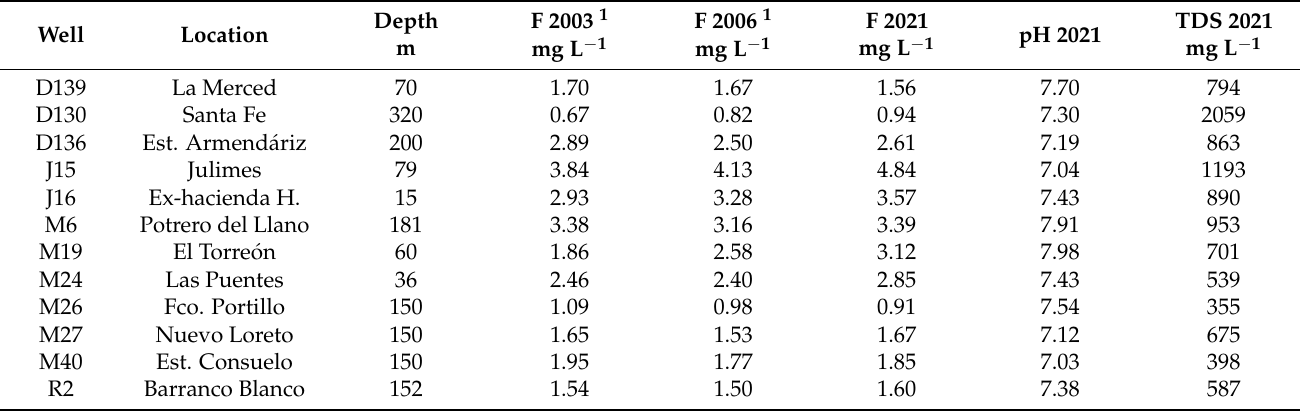
Table 1. Fluoride (F − ) concentrations, pH, and TDS in groundwater.